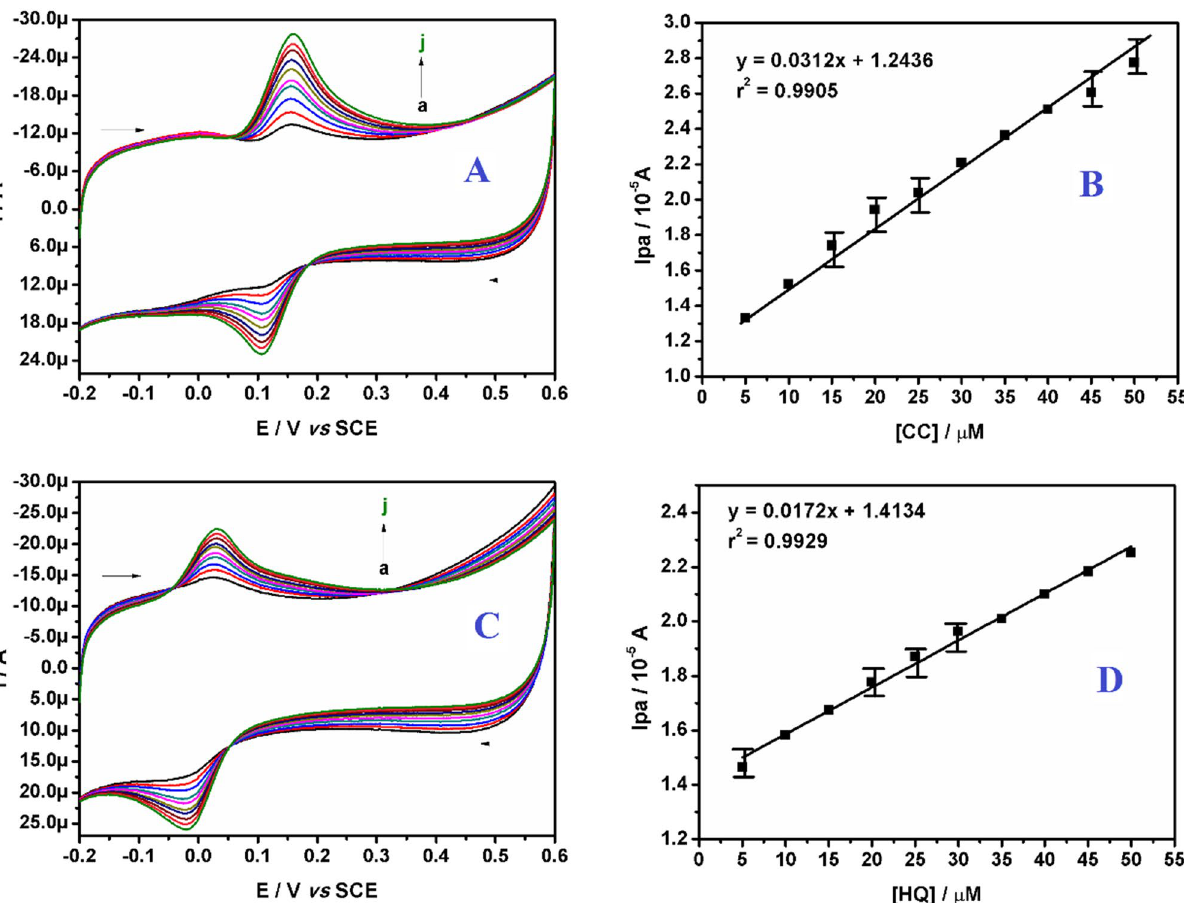
Figure 10. ( A ) CVs of polysorbate/CPE with different concentration of CC (5.0 to 50.0 μM) in buffer (0.2 M PBS; pH 7.4). ( B ) Linear plot of Ipa versus concentration of CC. (C) CVs of polysorbate/CPE with different concentration of HQ (5.0 to 50.0 μM) in buffer (0.2 M PBS; pH 7.4). ( D ) Linear plot of Ipa versus concentration of